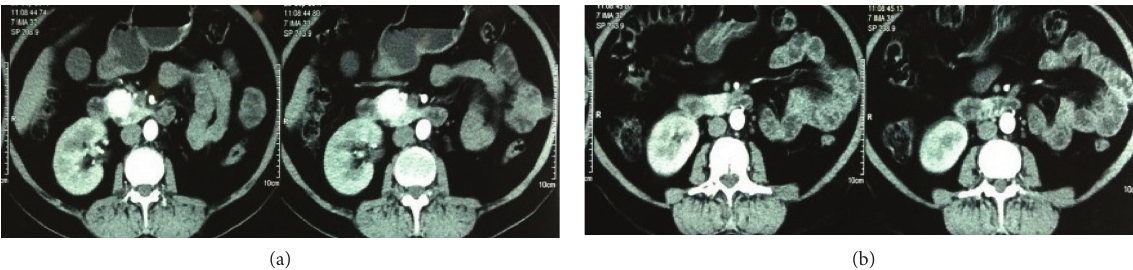
Figure 1: Hyperattenuating lesion in the anterior plane of the head of the pancreas (2.4cm × 2.3 cm × 2.1cm), bilateral adrenal hyperplasia, and nonvisualization of the left kidney.